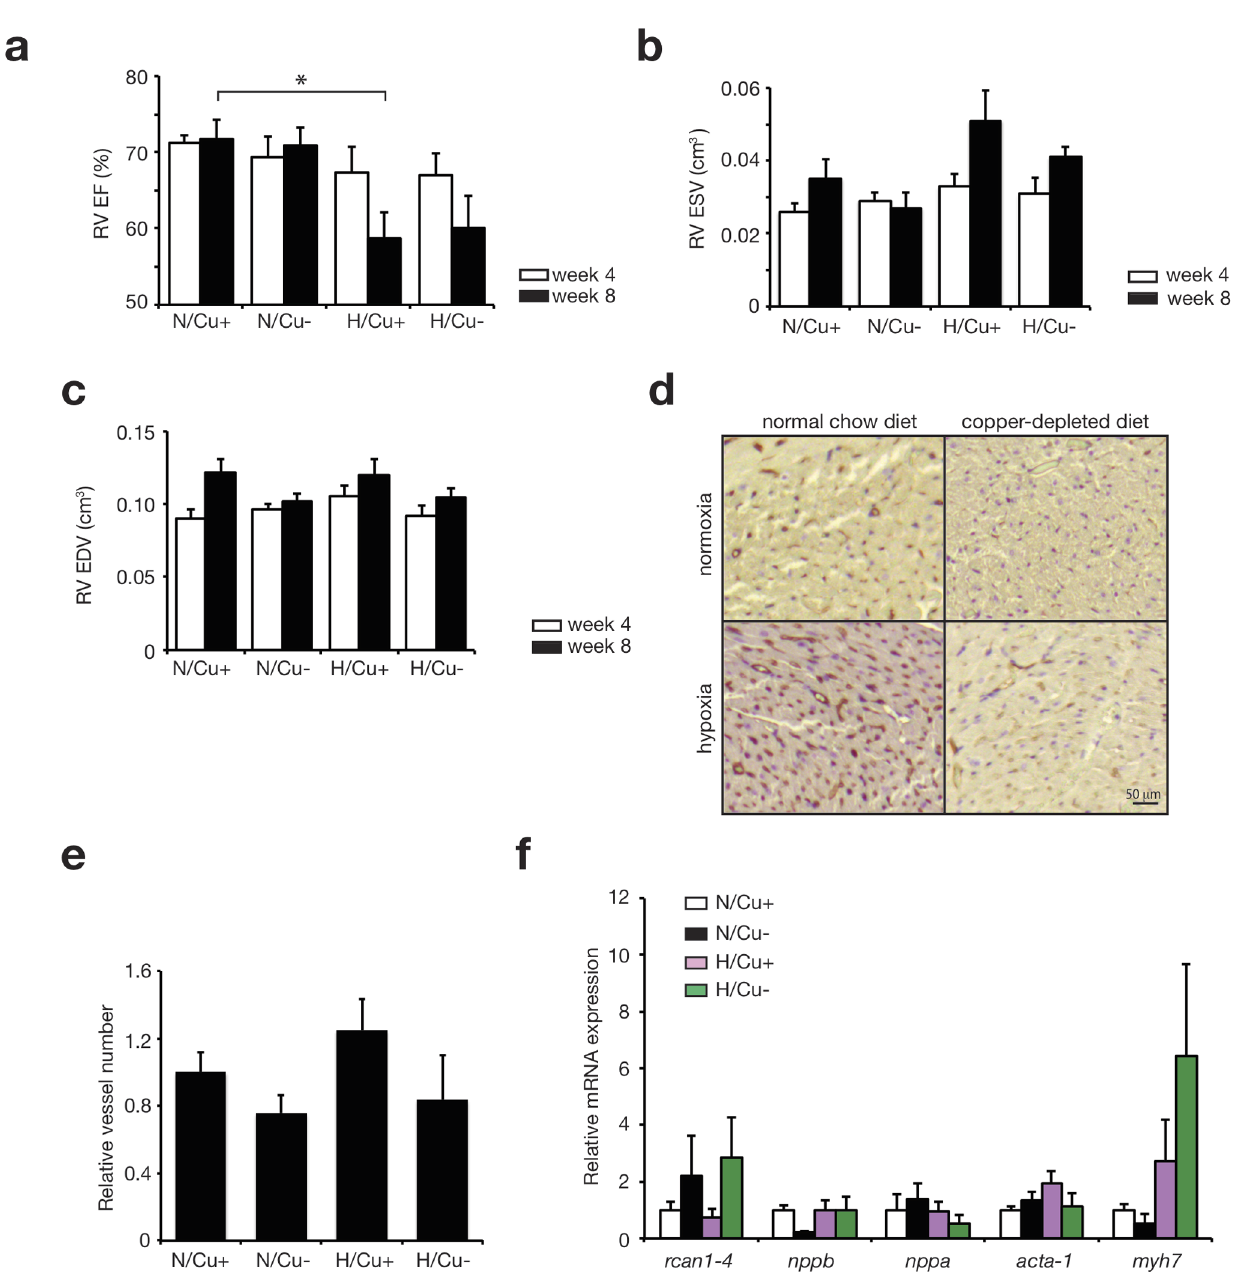
Figure 2. Chronic hypoxia induces a decrease in right ventricular ejection fraction. Right ventricular ejection fraction (EF) measured by MRI at 4 and 8 weeks. The following groups are compared: normoxia on normal chow diet (N/Cu + ), normoxia on copper depleted diet (N/Cu), hypoxia on normal chow diet (H/Cu + ) and hypoxia on copper depleted diet (H/Cu-). (b) Right ventricular end systolic volumes in cm 3 and (c) right ventricular end diastolic volumes in cm 3 . (n=6) (d) Griffonia simplicifolia 1 (GS-1)-stain on representative right ventricular free wall paraffin sections. (e) Quantification of GS-1 stain, expressed as relative vessel number. (f) Real-time PCR analysis of transcript abundance for cardiac stress marker genes in right ventricles at 8 weeks. (n=3) *P , 0.05 (mean 6 s.e.m.).